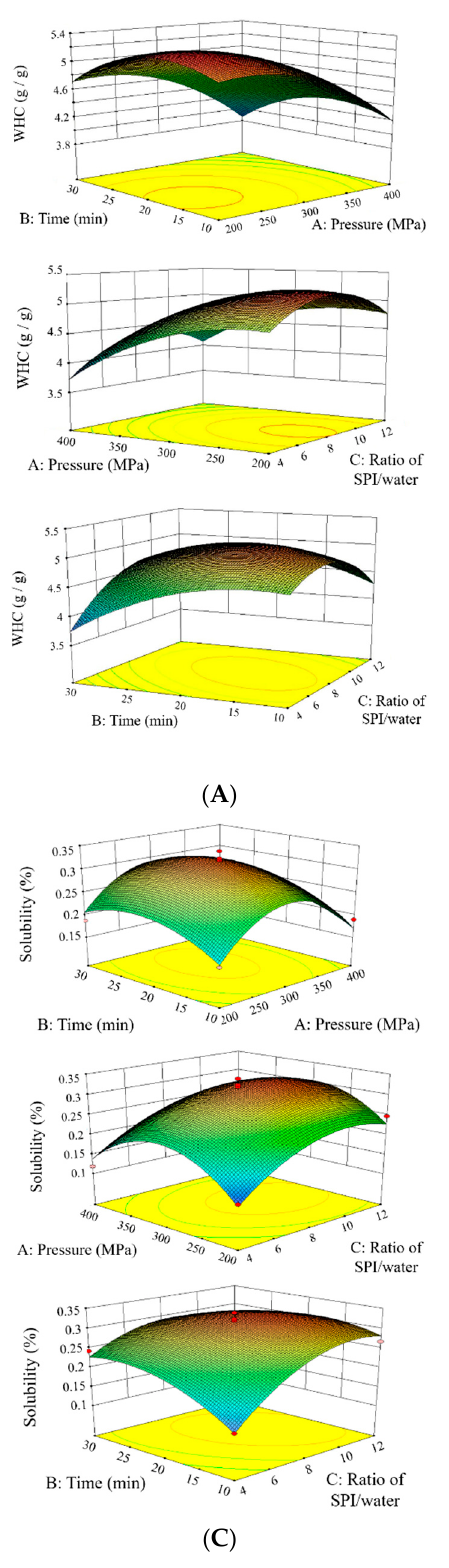
Figure 1. Response surface and contour plots for water holding capacity (WHC, A ), emulsifying activity index (EAI, B ), and solubility ( C ).